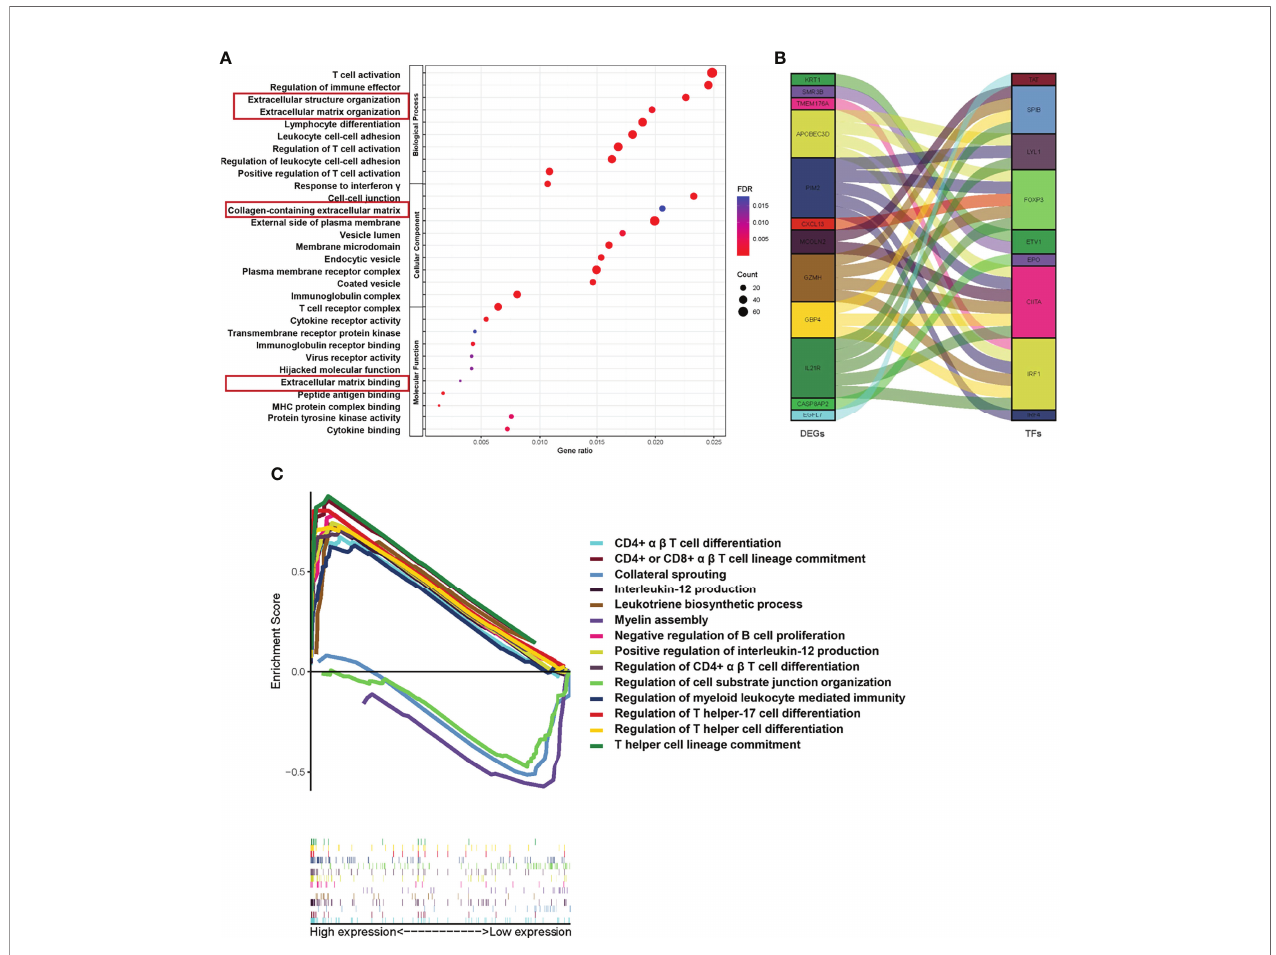
FIGURE 6 | Functional pathway analysis based on Treg expression in TNBC. (A) The results of GO analyses between different Treg expression groups into three functional groups, including biological process (BP), cellular component (CC) and molecular function (MF). (B) Coexpression analysis of DEGs and immune-related transcription factors (TFs). (C) GSEA of signi fi cant Gene Ontology biological processes between the Treg-H and Treg-L groups based on the enrichment